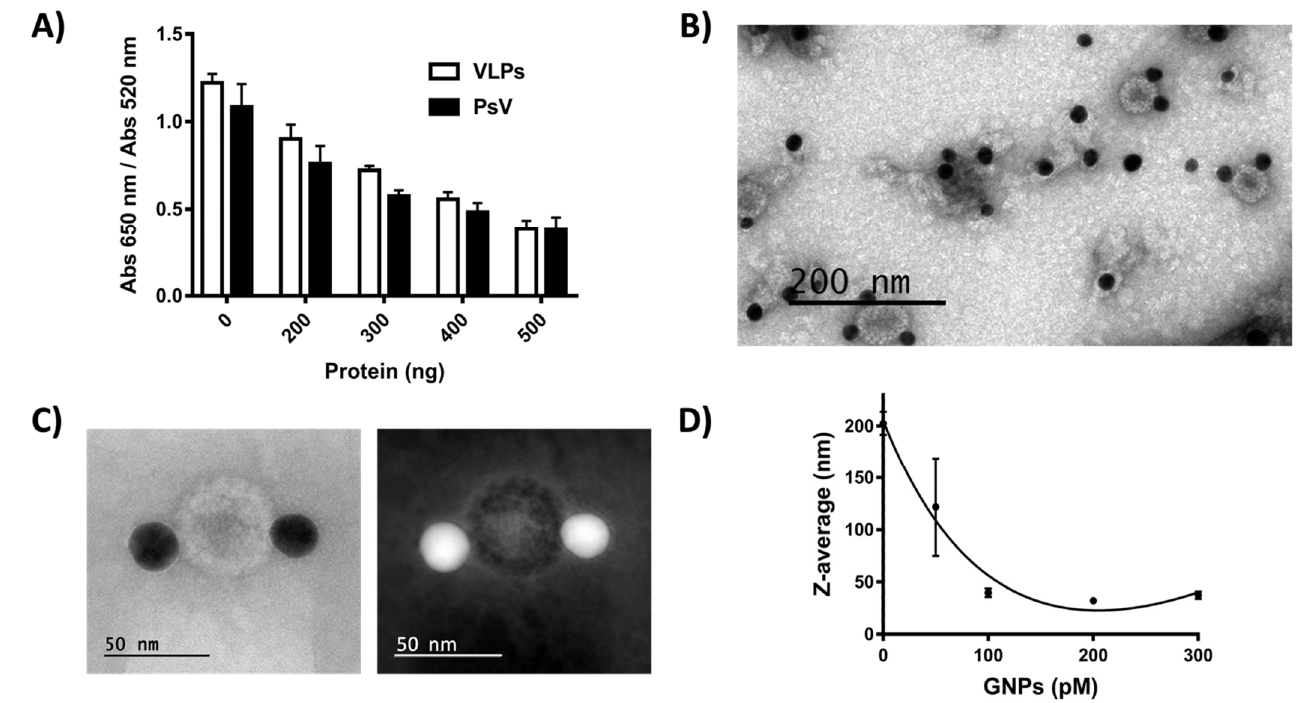
Figure 3. nfGNPs interact with PsV. ( A ) PsV inhibits aggregation of nfGNPs. nfGNPs (200 pM) were incubated with increasing amounts of L1/L2 VLPs (HPV16) and PsV (HPV16) (200, 300, 400 and 500 ng) in the presence of 70 mM NaCl. The graph represents the mean and standard deviation of three independent experiments. ( B ) Negative-stain TEM microphotography of PsV and nfGNPs (scale bar = 200 nm). nfGNPs decorate the surface of PsV. ( C ) Negative-stain HAADF-STEM of PsV and nfGNPs. ( D ) nfGNPs disaggregate PsV clusters. Purified PsV (400 ng) was incubated with increasing concentrations of nfGNPs (50, 100, 200 and 300 pM), and particle size was measure by DLS. The plot represents the average size of five measurements from the same sample.